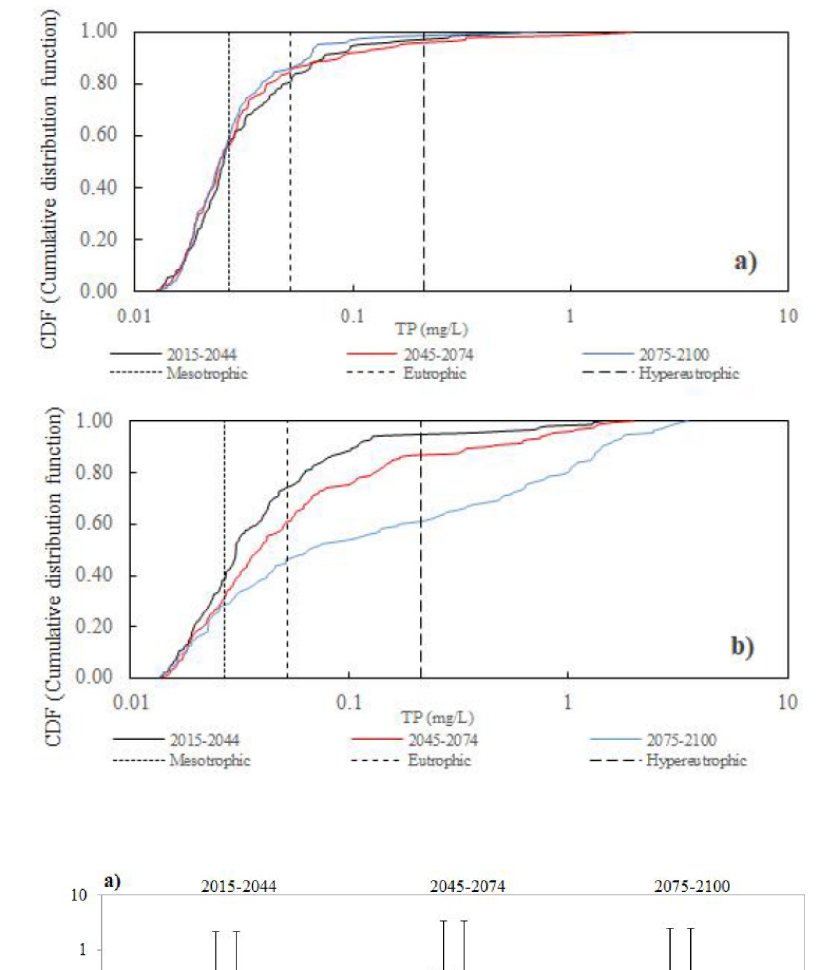
Figure 5. Seasonality of Total Phosphorus (TP) concentration in Orós reservoir using five different GCMs under a) SSP2-4.5 and b) SSP5-8.5 scenarios and three future periods. The rectangles without diagonal lines represent the rainy season, while the rectangles with diagonal lines, the dry